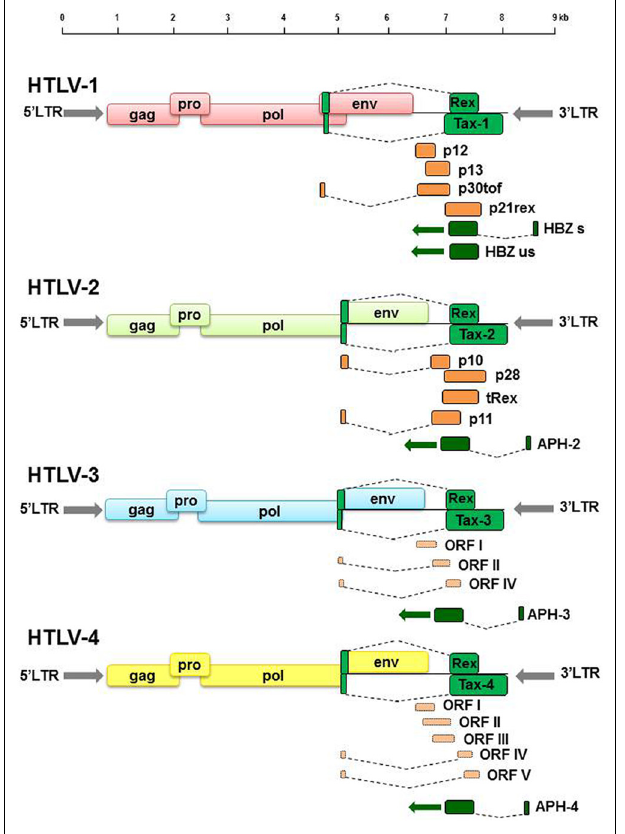
FIGURE 1 | Schematic representation of HTLV-1, HTLV-2, HTLV-3, and HTLV-4 genomic organization. Green colored boxes indicate ORF encoding regulatory proteins. Dark orange colored boxes indicate ORF encoding auxiliary proteins. Light orange colored boxes indicate putative ORF deduced by genomic sequences